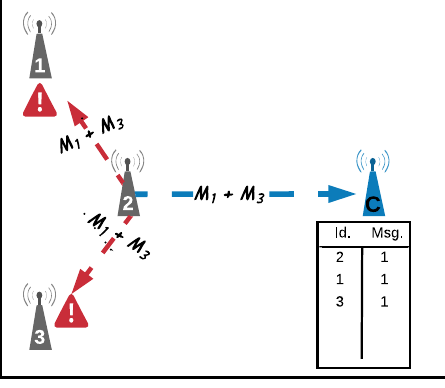
Figure 6. Retransmission